Question: Give a one-sentence summary of this figure.
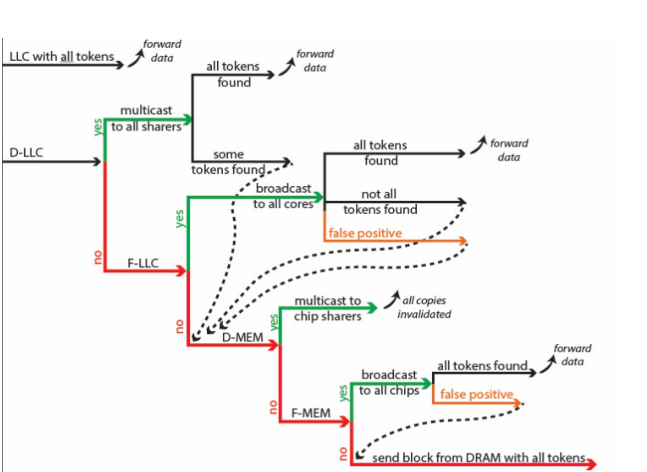
Answer: Timeline of a write miss and potential outcomes. (For readability  reasons, the time-scale is not proportional)